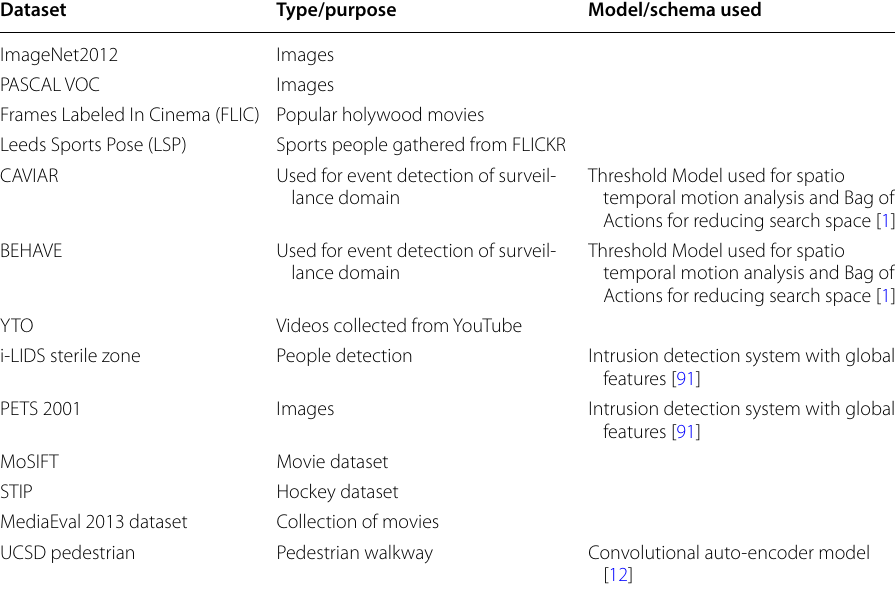
Table 7 Various